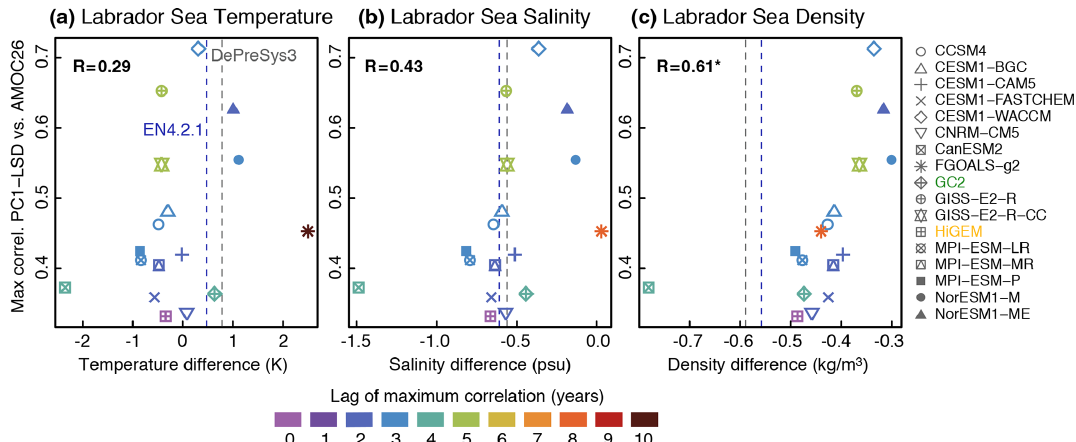
Figure 9. (a) Scatterplot of the maximum cross-correlation value in Fig. 4b between PC1-LSD and AMOC26 (without the Ekman com- ponent) against the climatological mean of the Labrador Sea temperature stratification index (computed as the difference of the vertical means in the levels 0–100m minus the vertical means in the levels 500–1000m; see Fig. 1). The maximum correlations are based on 10-year running trends. The correlation coefficient between the two metrics is shown in the top left corner. The presence of an asterisk indicates that the correlation is significant at the 95% confidence level. Colours indicate the lag at which the maximum correlation between PC1-LSD and AMOC26 is obtained. The grey (blue) vertical lines depict the mean stratification value in the DePreSys3 assimilation run (EN4.2.1). In both cases, their overlap period is used to compute the climatology (i.e. 1960–2013). (b–c) The same as in (a) but for the Labrador Sea salinity and density (defined as σ 2 ),